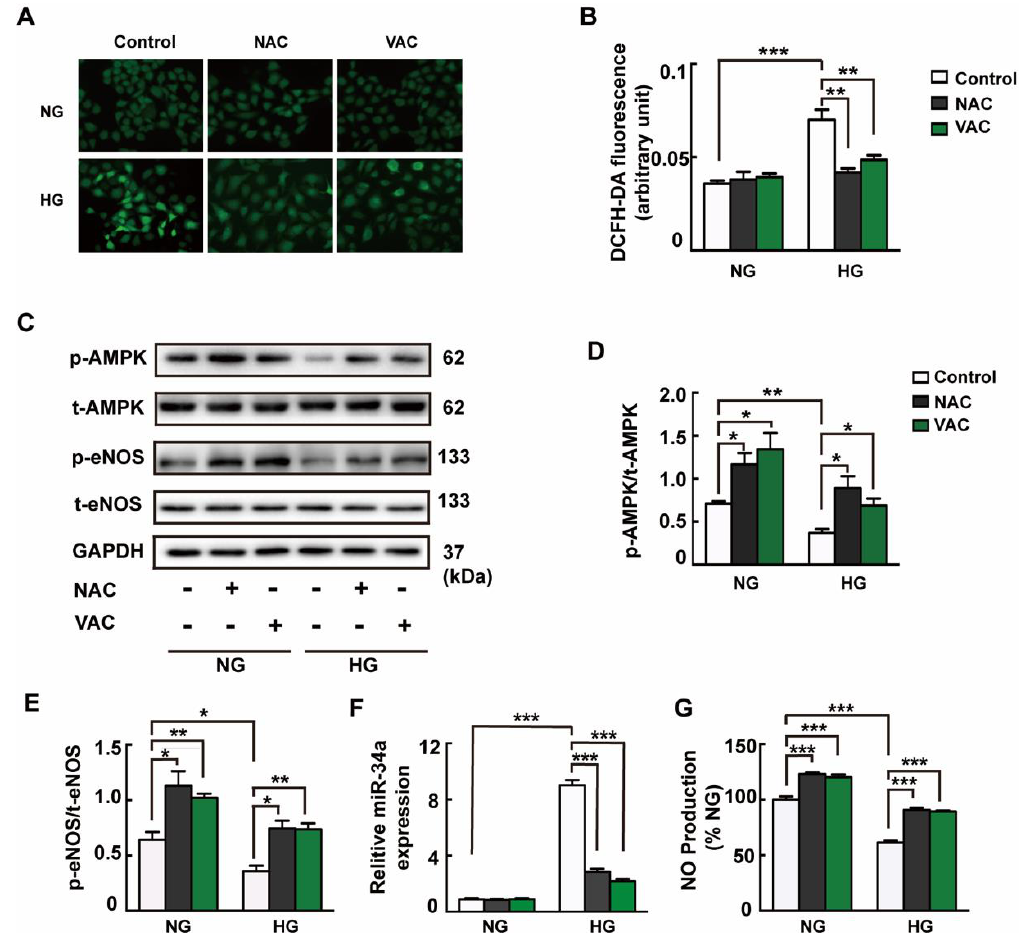
Figure 5. ROS were responsible for HG-induced endothelial dysfunction. The HMEC-1 cells were pre-incubated with vaccarin (5 µ M) for 12 h or ROS scavenger NAC (500 µ M) for 1 h before 35 mM HG incubation for another 48 h. ( A ) Representative microscopic scans of ROS (magnification × 400). ( B ) Averaged fluorescence intensity of DCFH-DA. ( C ) Representative blots showing protein expressions of p-AMPK and p-eNOS in HMEC-1 cells. Bar groups showing that the quantification of p-AMPK / t-AMPK ( D ) and p-eNOS / t-eNOS ( E ). E ff ects of NAC (500 µ M) on the miRNA-34a expression ( F ) and NO generation ( G ) in response to HG. Values are mean ± SEM. * p < 0.05, ** p < 0.01, *** p < 0.001. n = 3 for each group in C–E; n = 6 for A; n = 5 for other groups. NAC, N-acetyl-L-cysteine.